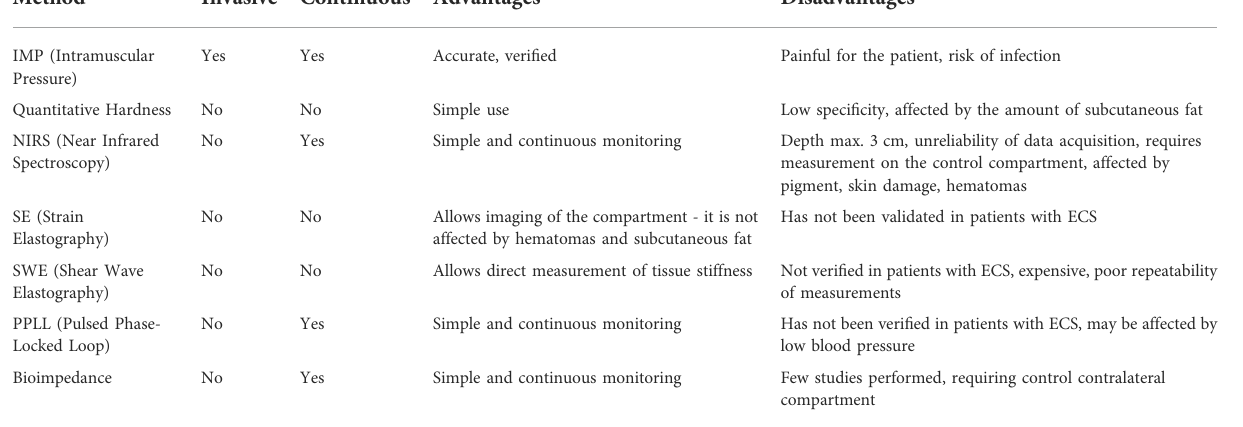
TABLE 1 Comparison of available diagnostic